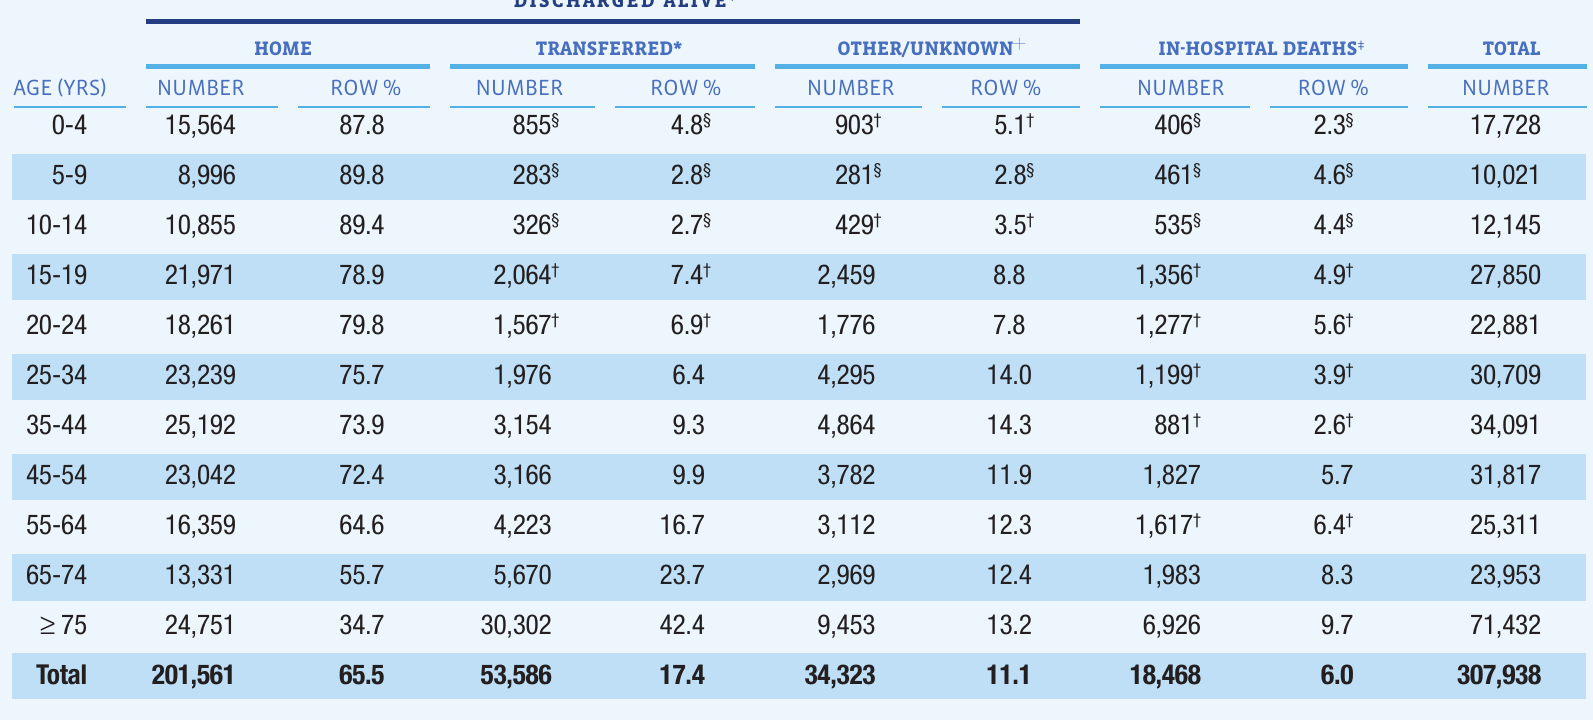
TABLE 8: Estimated Average Annual Numbers and Percentages of Traumatic Brain Injury-Related Hospitalizations, by Age Group and Disposition, United States,